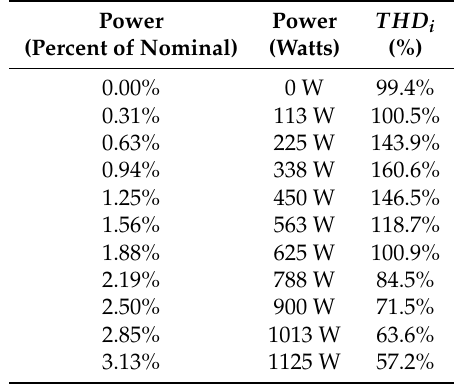
Table 1. Inverter Power Commands and THD i